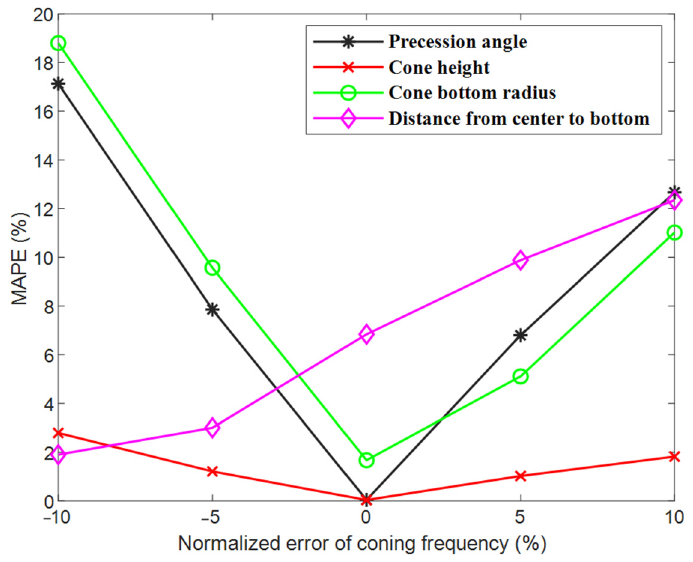
white noise into the echo signal. When SNR is − 10 dB, the echo micro-Doppler curves and